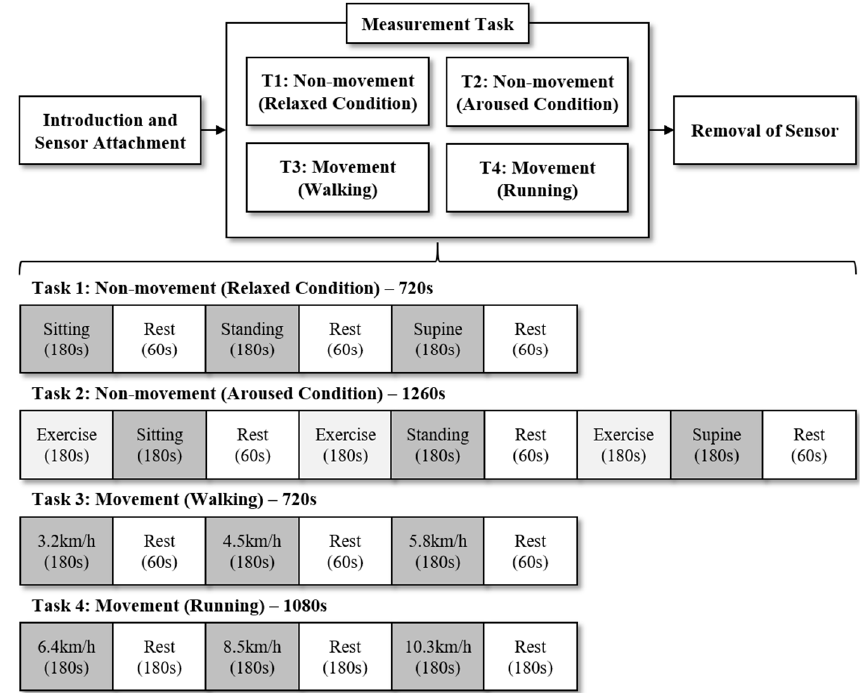
Figure 1. Experimental procedure according to two physical conditions, three body postures, and six movement speeds. The experiment lasted for a total of 63 min and sufficient rest was given between each task.